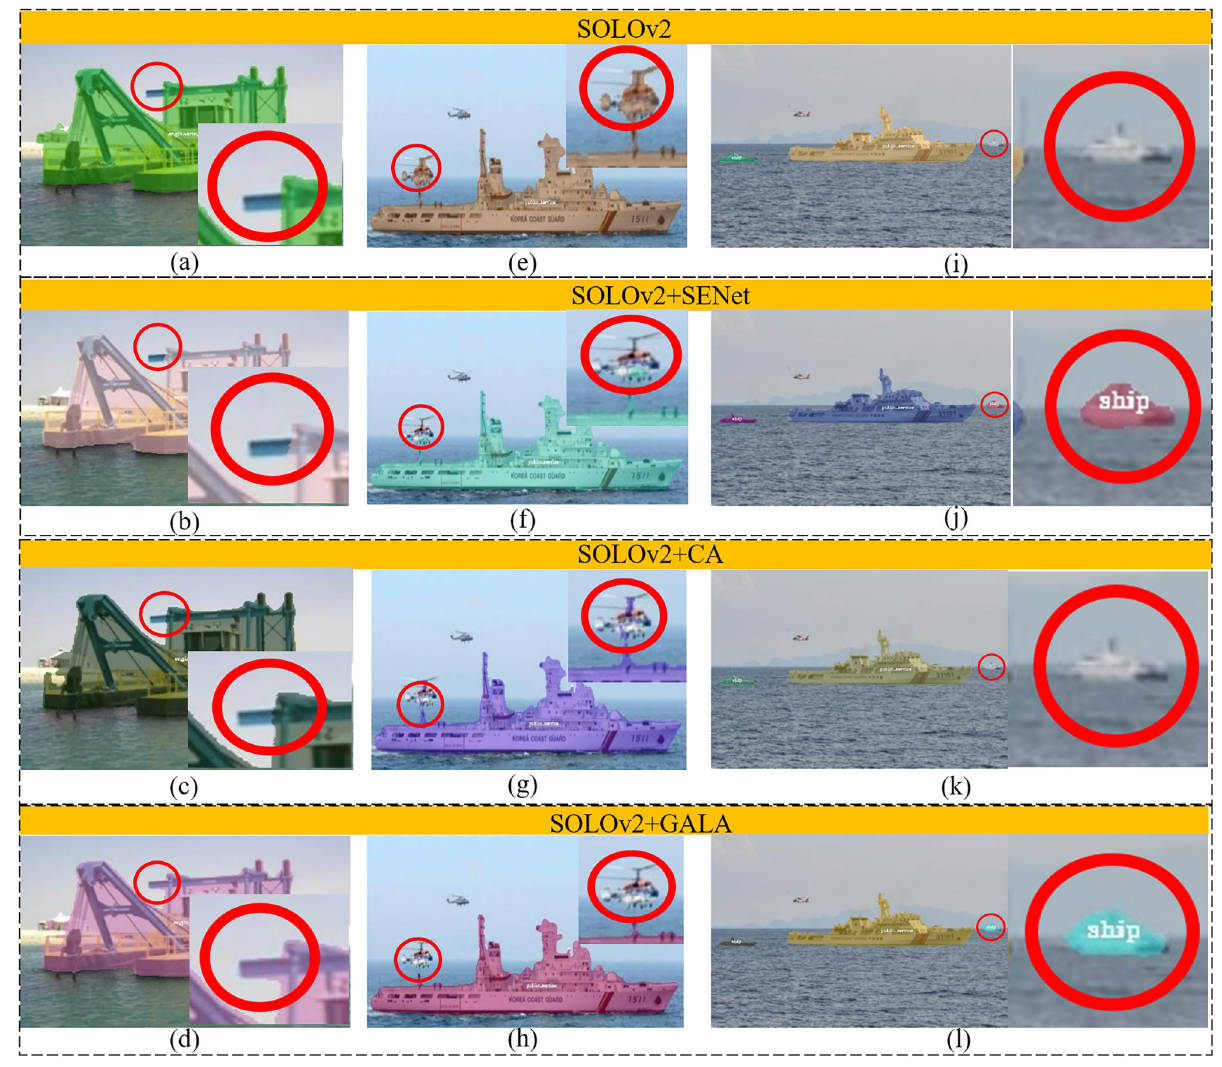
Fig 12. Comparison of segmentation results for several typical ship examples, selected from MariBoatsSubclass. The first row (a, e, i): segmentations of SOLOv2. The second row (b, f, j): the segmentations of SOLOv2+ SEnet. The third row (c, g, j): the segmentations of SOLOv2+ CA. The last row (d, h, l): the segmentations of SOLOv2 using the proposed GALA